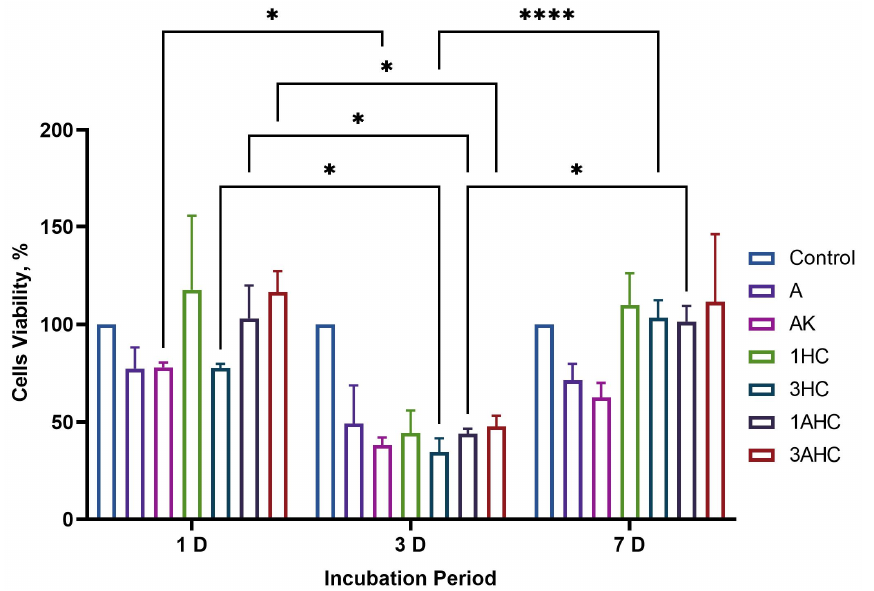
Figure 12. The percentage of cell viability was taken after 1 day, 3 days, and 7 days incubation. The cells’ viability decreased after 3 days, but an improvement in cells’ viability was observed after 7 days of incubation on every fabricated bioscaffold. On day 7, the CHAK bioscaffold showed better cell viability compared to the non-added carbon bioscaffold. Statistical significance was considered at a probability of p < 0.05 (* p ≤ 0.05, **** p ≤ 0.0001).